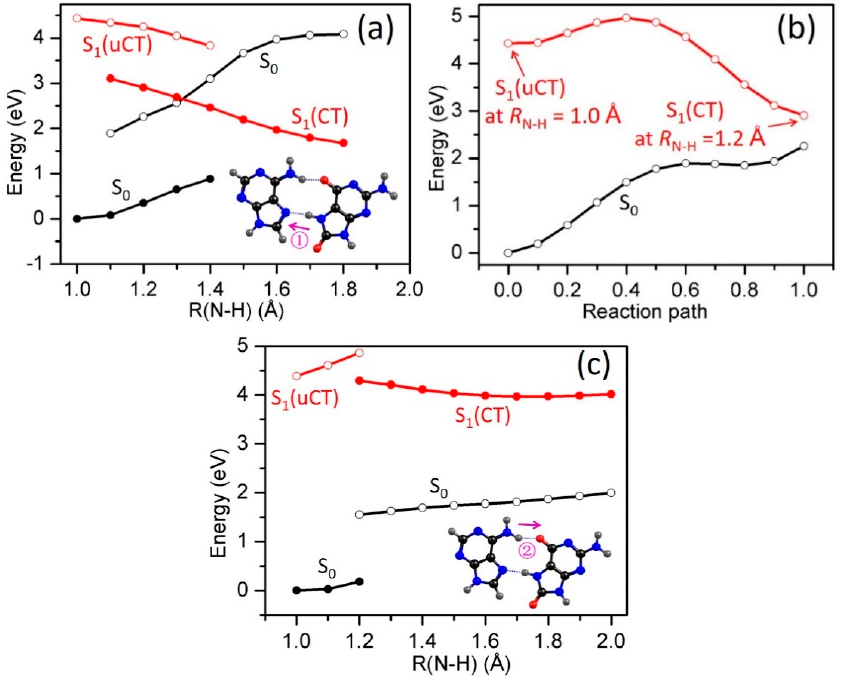
Figure 4. PE profiles of the ground state and the lowest singlet excited states of the HG2 8-oxo-G − -A base pair along the R N7 − H13 ( a ) and the R N10 − H12 ( c ) proton-transfer coordinates; ( b ) shows the energy profiles of the LIIC path connecting S 1 (uCT) with S 1 (CT) in